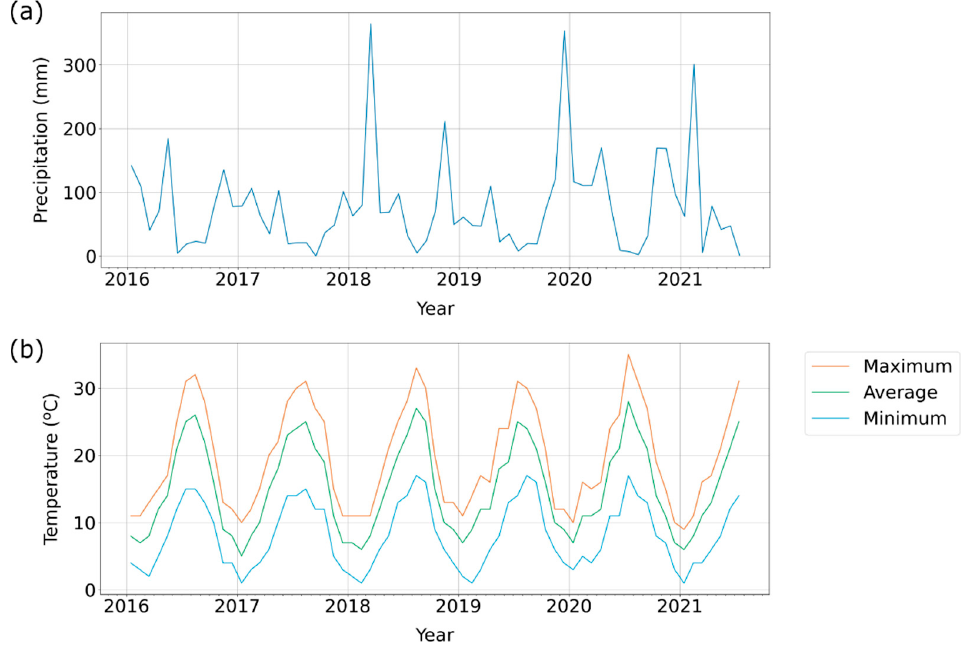
Figure A2. Accumulated monthly precipitation ( a ) and monthly temperatures ( b ) for the region of Covilhã, Castelo Branco, Portugal from January 2016 to June 2021 (Source: https://www.worldweatheronline.com/covilha-weather-averages/castelo-branco/pt.aspx, accessed on 14 September 2021). Vertical gridlines indicate the first day of each year.